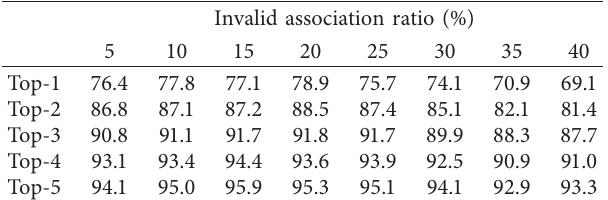
Figure 7: Model detection performance (a) TPR, (b) FPR, and (c) accuracy with invalid association ratio ranging from 0.05 to 0.6. Table 3: Model performance in rematching invalid associated fare machines.